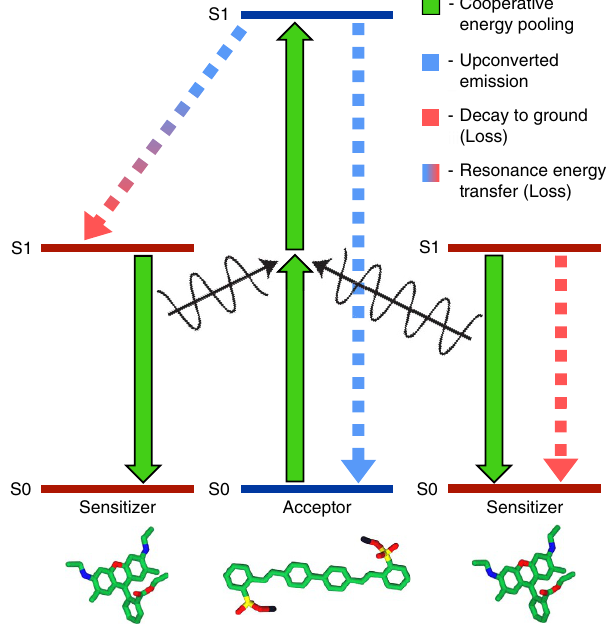
Figure 1 | Kinetic diagram of cooperative energy pooling. Two excited sensitizer chromophores (sensitizers) simultaneously transfer their energy to an acceptor chromophore via resonant coupling with the 2PA tensor of the acceptor, resulting in a lowest-lying singlet excitation on the acceptor. S0 and S1 are the ground and first excited singlet states, respectively. Emission of an upconverted photon from the acceptor is measured to detect CEP. Energy loss pathways are shown as FRET from acceptor to sensitizer (blue-to-red arrow) and sensitizer decay (red arrow). Non- radiative decay loss pathways are not